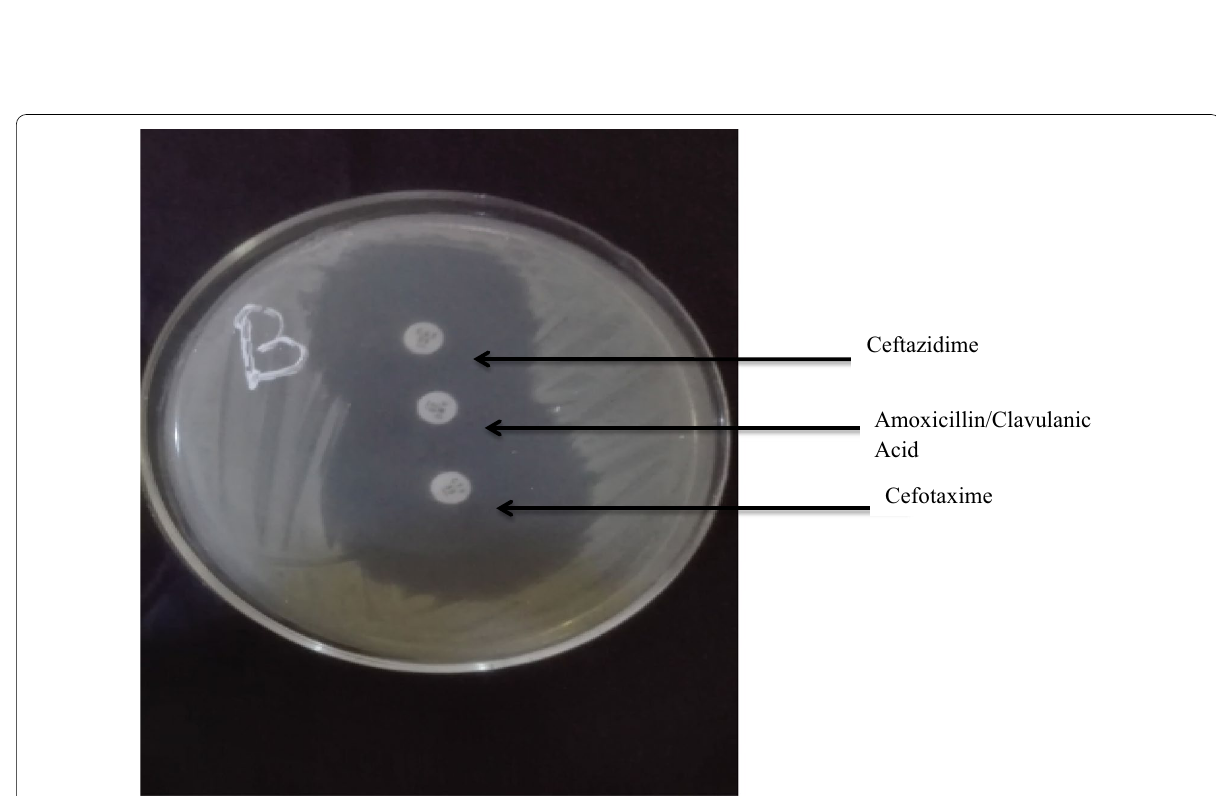
Fig. 4 ESBL-positive